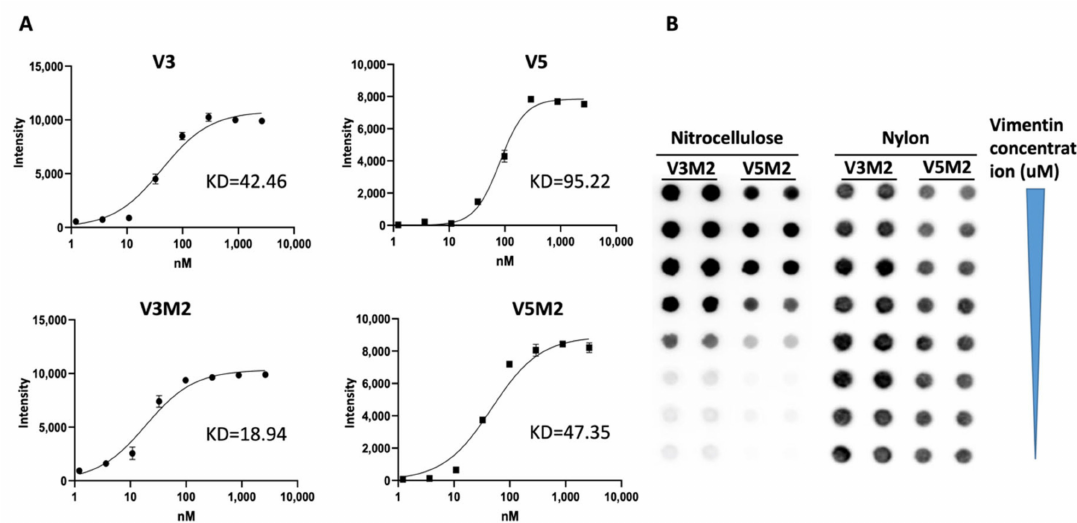
Figure 3. The binding affinity of V3, V5, selected motifs and their equilibrium dissociation constant. Filter-binding assays were performed with the biotinylated V3, V5, V3M2, V5M2 thioaptamers and purified vimentin protein. Chemiluminescent detection of spot intensities on the nitrocellulose membranes was used to quantitate the thio-aptamer binding affinity. ( A ) Saturation binding curves were generated and the equilibrium dissociation constants, Kd, were calculated from the equation Y = Bmax × X/(Kd + X), assuming a single binding site. Bmax represents the maximum binding capacity of aptamer bound to vimentin protein. X is the protein concentrations and Y is the calculated spot intensity. ( B ) Representative spot image of biotinylated V3M2 and V5M2 binding with vimentin protein retained on the nitrocellulose membrane. Non-binding motifs stained on a nylon